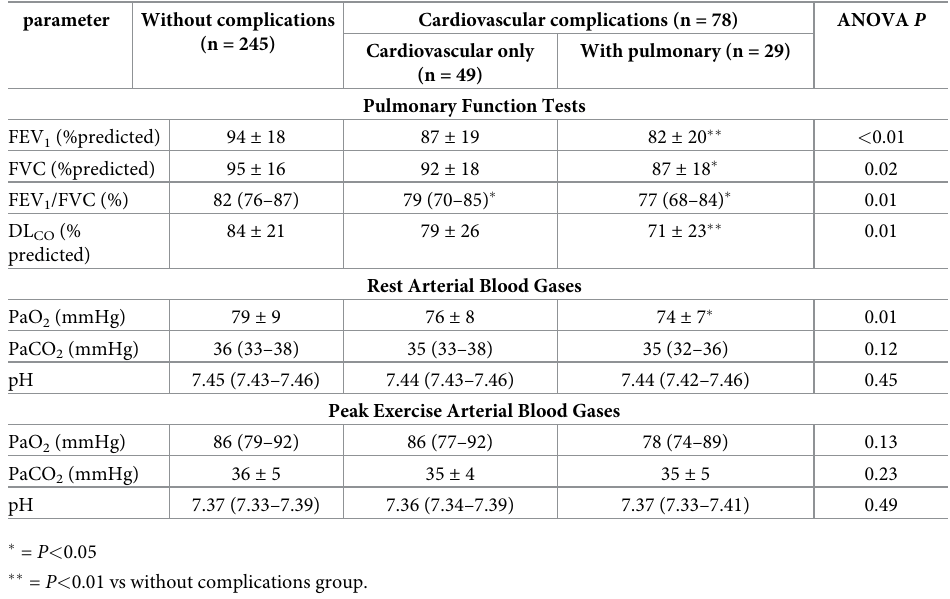
Table 3. Pulmonary function tests and arterial blood gases